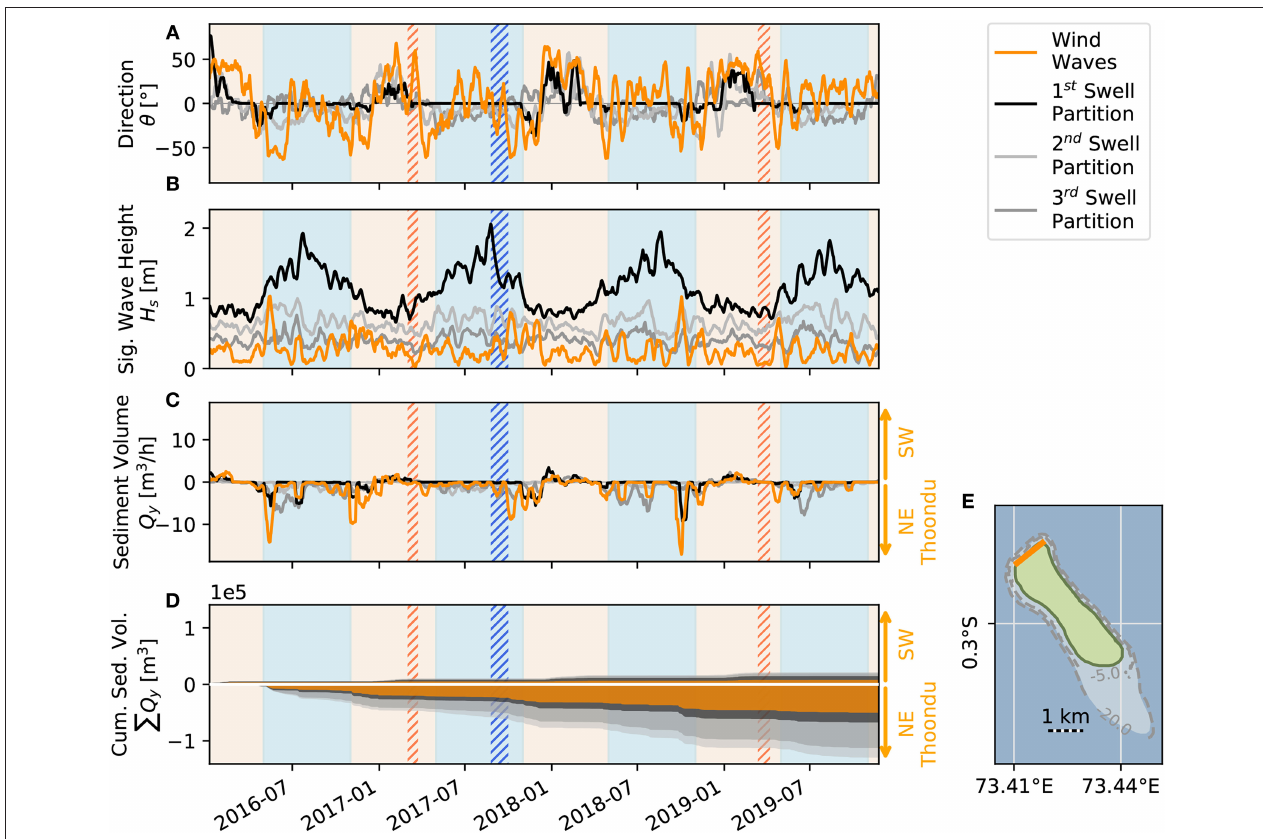
FIGURE 7 | (A) Averaged incident wave direction θ ⊥ , wp , measured as difference from the coastline normal α ⊥ and (B) wave height H s , wp of each wave partition wp used for (C) longshore sediment transport rates q y , wp and (D) cumulative sediment volume Q y , wp , transported alongshore the, marked with an orange line on the map in (E) . The orange line is accordance with the orange line in Figure 6 (see Table 3 for corresponding peak transport rate values q y , max and the contribution of each wave partition to Q y ). The time series shows values from January 2016 to November 2019. Positive values for q y , wp and Q y , wp indicate a transport toward southwest, while negative values lead to sediment transport toward Thoondu beach in the northeast. The time series shows the dry season with orange and the wet season with blue background. Field campaign 1 and 3 (orange hatched area) took place in March 2017 and 2019. Field campaign 2 (blue hatched area) was conducted in September